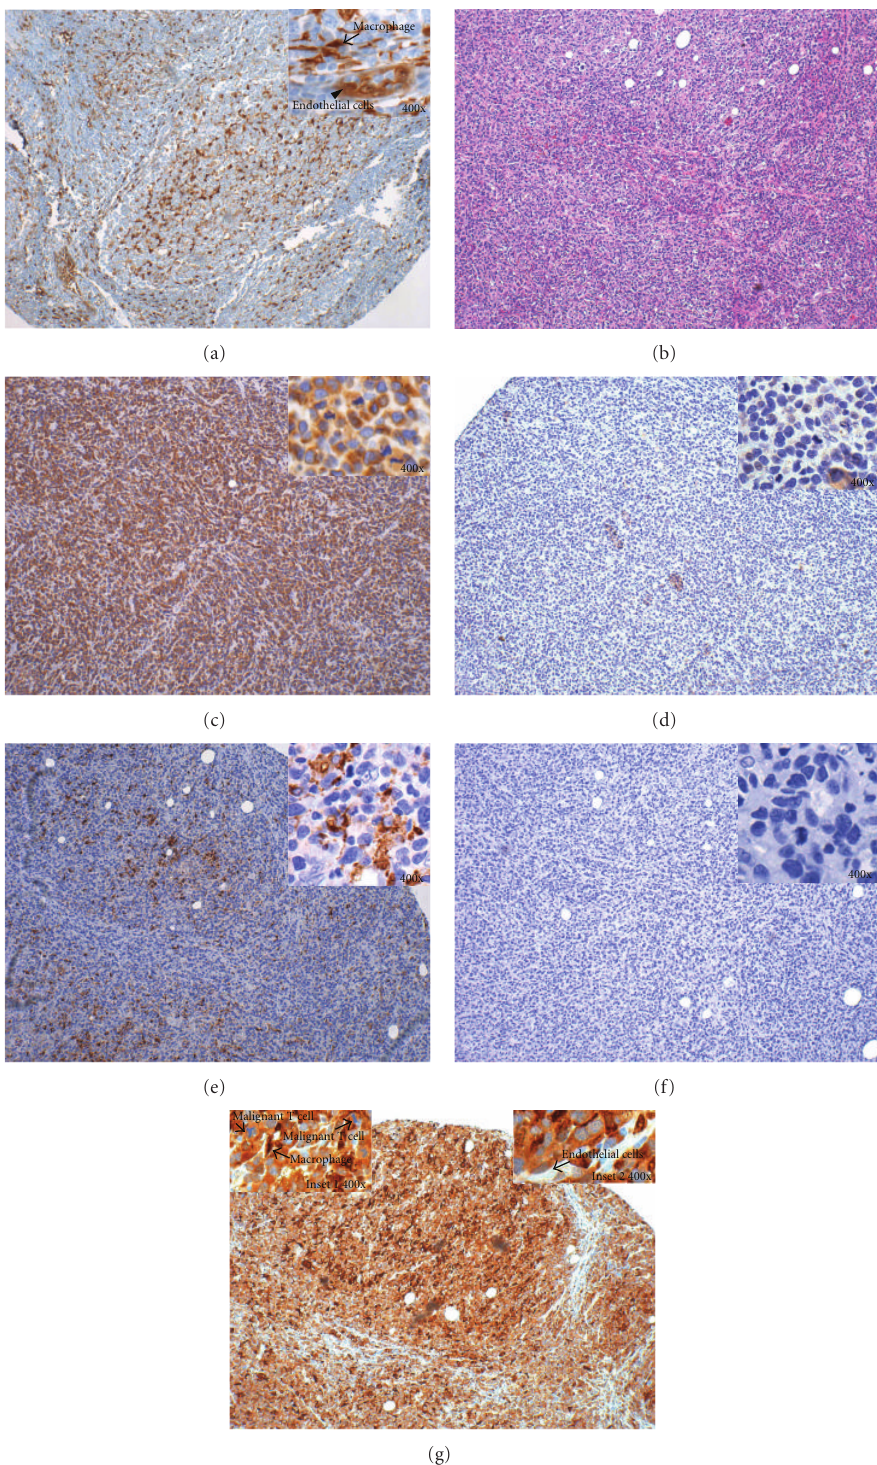
Figure 1: Immunohistochemical staining of thymidine phosphorylase (TP) expression and related markers in benign lymph node (a) and in lymph node with malignant mycosis fungoides/S´ezary syndrome cells (LN-MF) (b–g). (a) In benign lymph node, TP expression highlights the meshwork of macrophages (arrow in inset; 400x) and endothelial cells (arrowhead in inset; 400x). (b) LN-MF: hematoxylin and eosin (H&E) stain. (c) CD3 highlights the malignant T cells and reactive T cells in LN-MF. (d) CD4 is weakly expressed in the malignant T cells in LN-MF. (e) CD68 highlights the macrophages in LN-MF. (f) CD21 is negative in this case of LN-MF. (g) TP highlights the macrophages (cytoplasmic/nuclear pattern, arrowhead in inset 1; 400x) and the malignant T cells (cytoplasmic pattern, arrow in inset 2; 400x) in a cytoplasmic staining pattern. Multiple mitotic figures are also noted in the malignant T cells. Images are from an Olympus BX41 microscope (Olympus Corp., Tokyo, Japan) processed with Qcapture Pro 5.1 (QImaging, Surrey, BC,